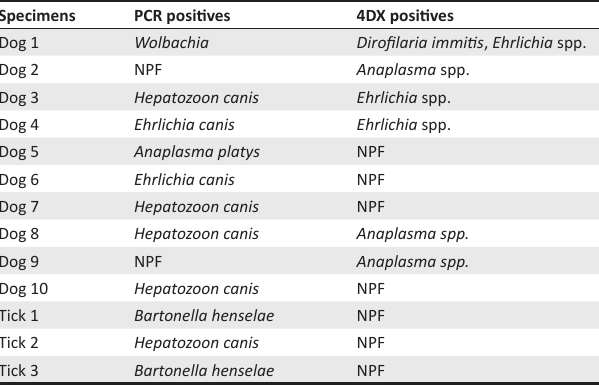
TABLE 1: Polymerase chain reaction and 4DX positive result for collected blood, serum and tick samples.